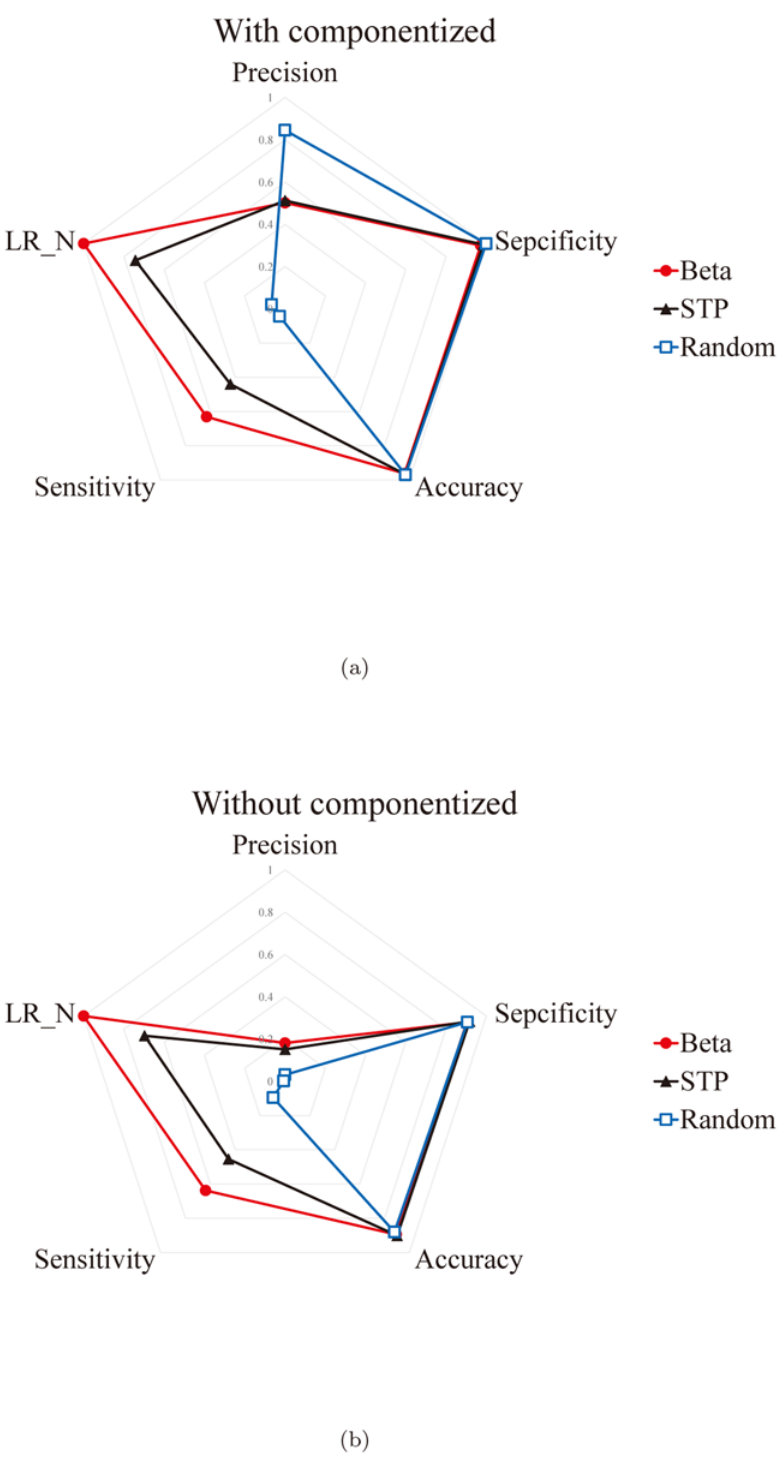
Fig 23. The radar charts of the proposed algorithm, the STP algorithm, and the Random method for the five statistical measures. (a) The case corresponding to the five best pockets recognized by the proposed algorithm, and (b) the case corresponding to the best pocket recognized by the proposed